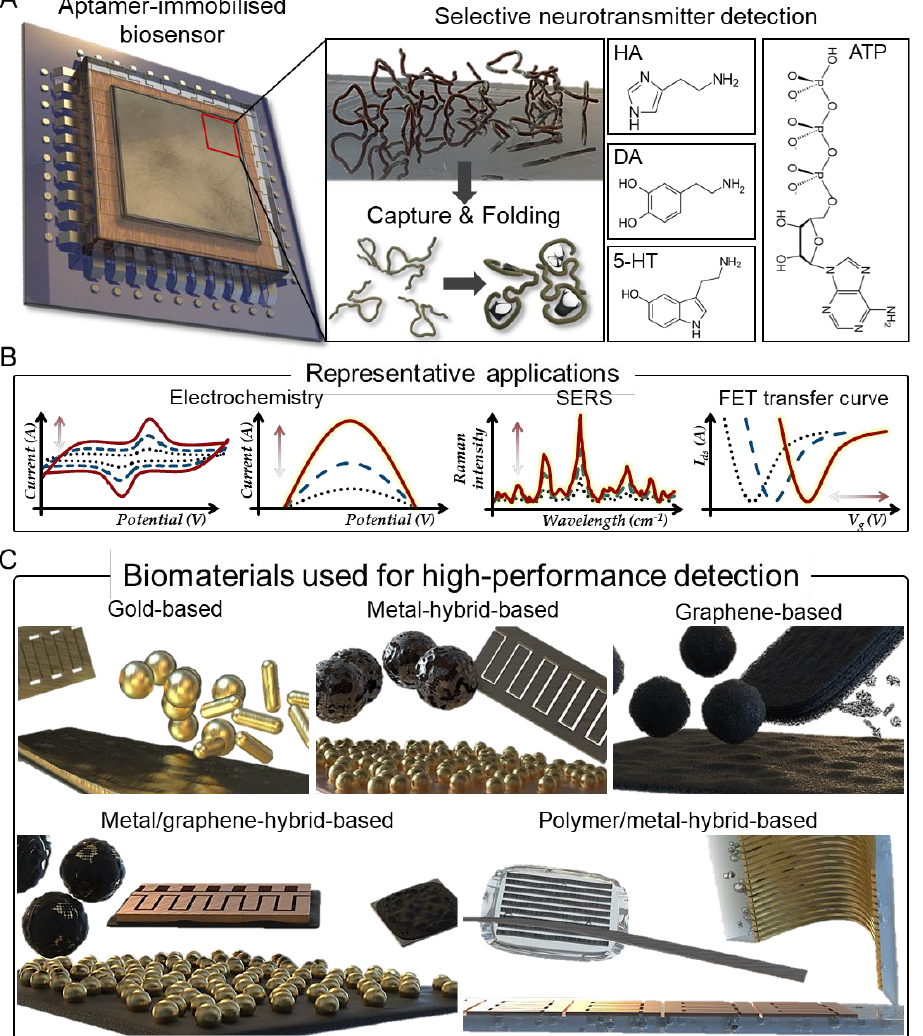
Figure 1. Aptamer biosensors for selective neurotransmitter detection. ( A ) Schematic indicating selective neurotransmitter detection with capture and folding process of aptamer. ( B ) Representative detection applications of aptamer-based biosensors. ( C ) Various forms of aptamer-based biosensors for high-performance detection applications.